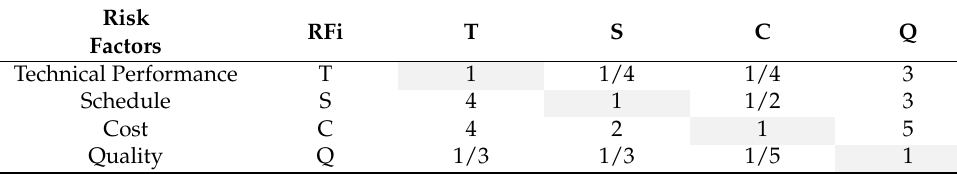
Table 4. Reciprocal matrix of the weighted risk factors (WRFs).